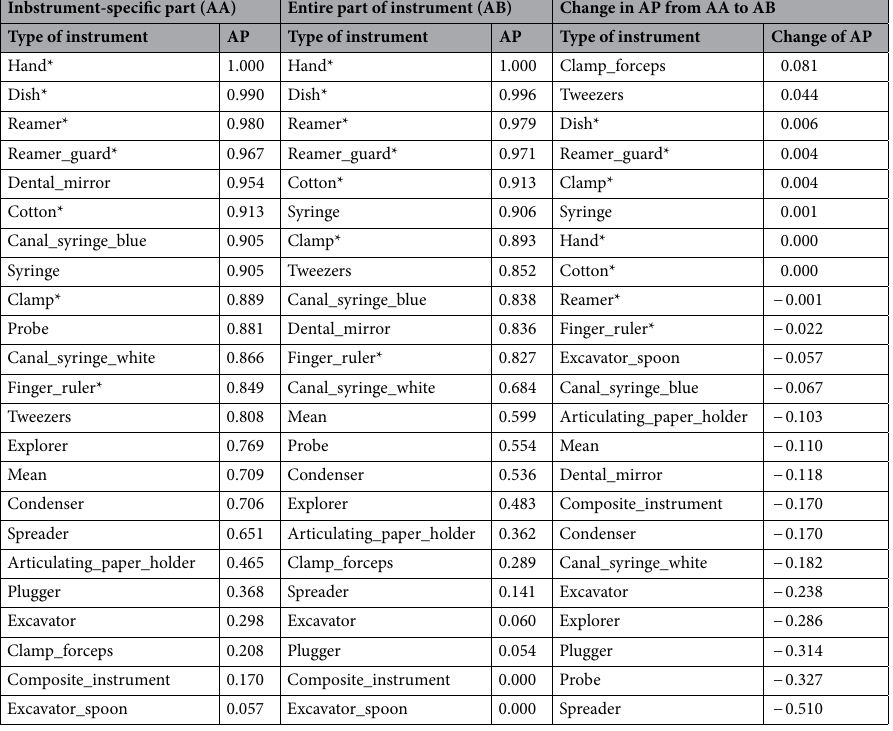
Table 4. AP of each instrument and changes according to annotation method